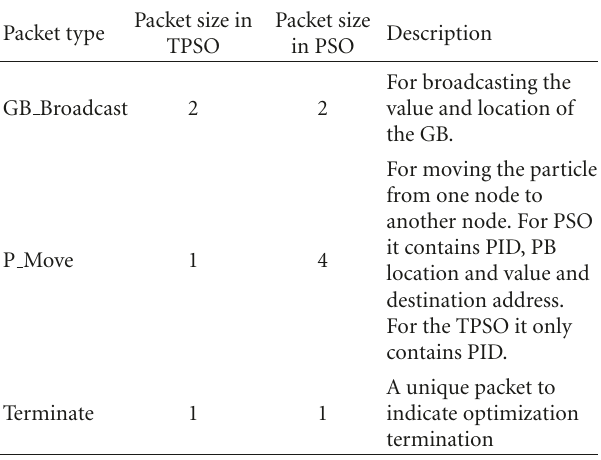
Table 2: PSO and TPSO packet sizes and description used in the simulation.